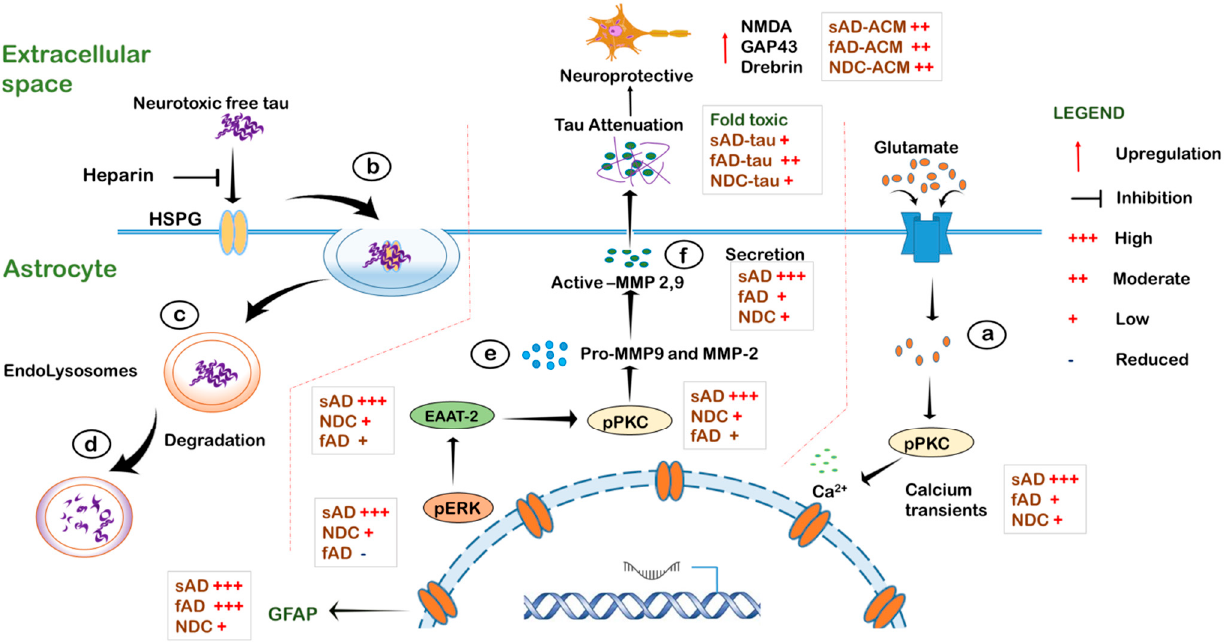
Figure 8. Schematic showing differential responses in the control and Alzheimer’s disease iPSC-derived astrocytes. ( a ) Astrocytes generated from Alzheimer’s disease (sAD and fAD) show increased glutamate-induced calcium transients in terms of amplitude and duration when compared to healthy astrocytes (NDC). ( b ) Extracellular free tau, which is neurotoxic, is taken up by astrocytes via heparin sulphate proteoglycan (HSPG), a process mitigated by heparin. Upon tau exposure, only AD astrocytes exhibit GFAP upregulation and morphological reshaping, attributes of reactive state. Tau is processed in the endo-lysosomal compartment ( c ) and degraded ( d ). Meanwhile, the uptake of tau activates ERK pathway with highest levels of pERK, EAAT-2 and pPKC in sporadic AD-derived astrocytes (sAD), leading to the upregulation of astrocytic pro-MMP-2 and MMP-9 ( e ), which results in differential activation and secretion ( f ). The capacity to degrade and attenuate extracellular tau was the highest when using the secretome of sAD and NDC astrocytes compared to fAD, and showed a neuroprotective effect accompanied by an increase in the levels of neuronal NMDA, GAP43 and drebrin.